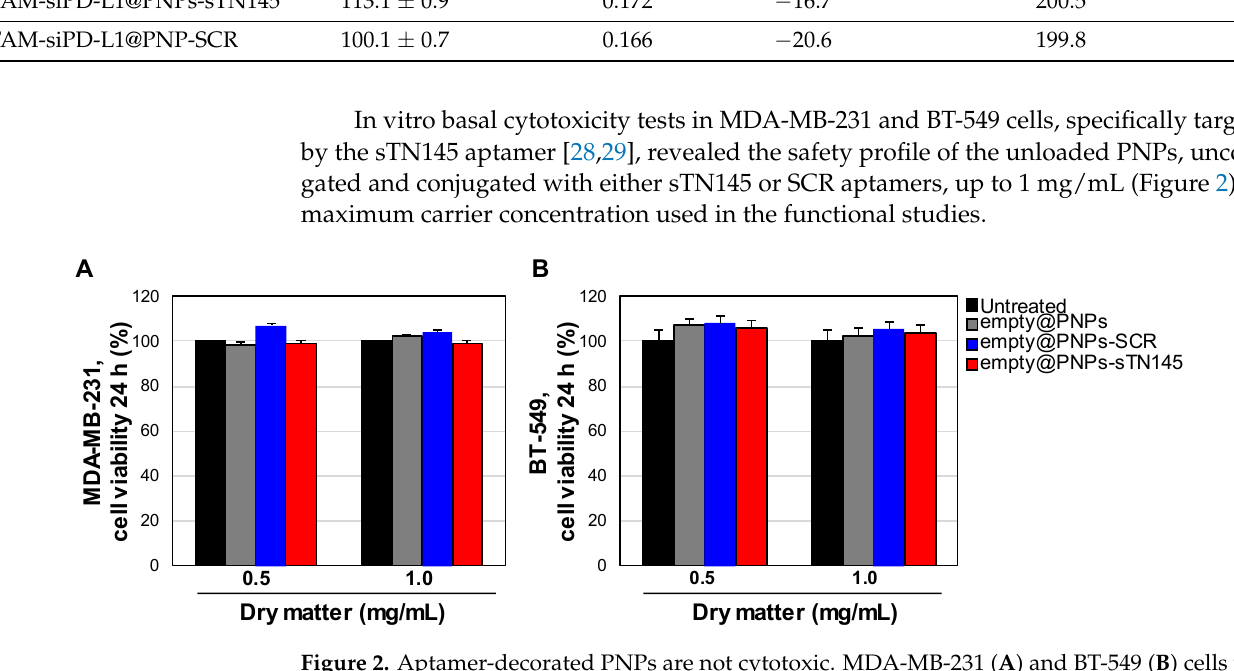
Figure 2. Aptamer-decorated PNPs are not cytotoxic. MDA-MB-231 ( A ) and BT-549 ( B ) cells were left untreated or treated for 24 h with the indicated amount of unloaded PNPs (empty@PNPs, empty@PNPs-SCR or empty@PNPs-sTN145). Cell viability was determined and expressed as the percent of viable treated cells with respect to untreated cells. Bars depict means ± SD of three independent experiments.